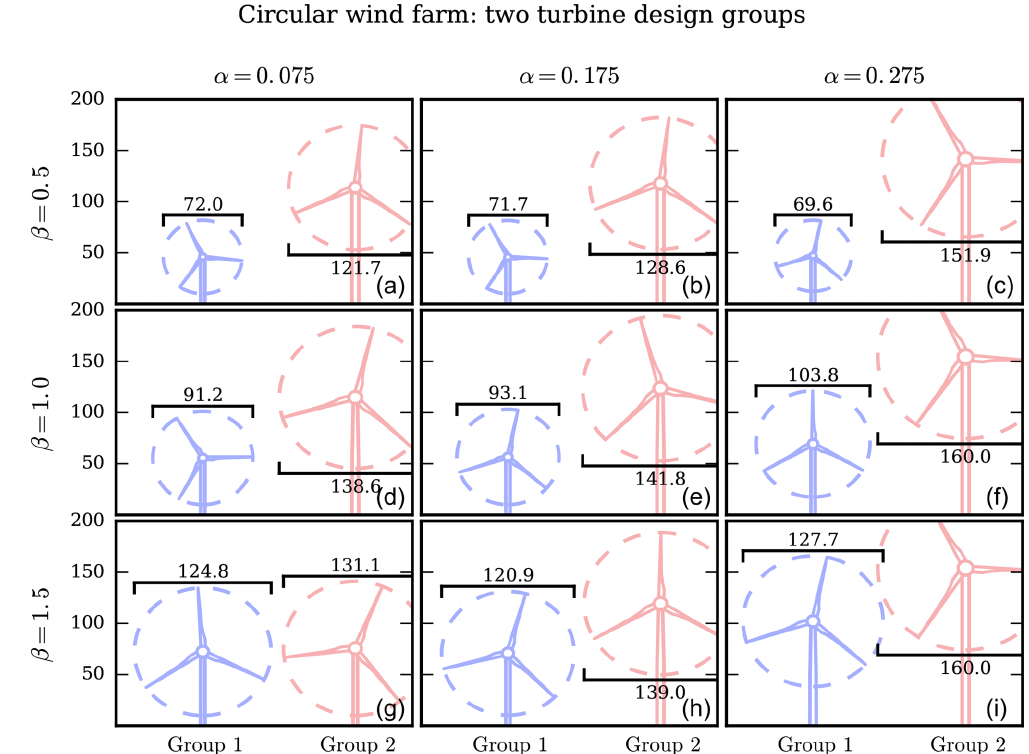
Figure 13. The optimal turbine heights and rotor diameters for the optimization runs with coupled layout and turbine design with two different turbine design groups for the circular wind farm. Each column shows a different shear exponent, with α = 0 . 075, 0 . 175, and 0 . 275 from left to right. Each row shows a different farm spacing multiplier, with β = 0 . 5, 1 . 0, and 1 . 5 from top to